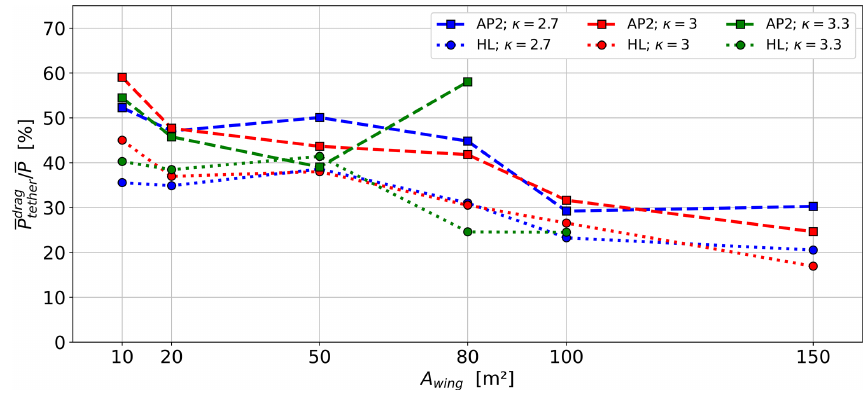
drag to produced power P over aircraft size A for both sets of aerody- tether